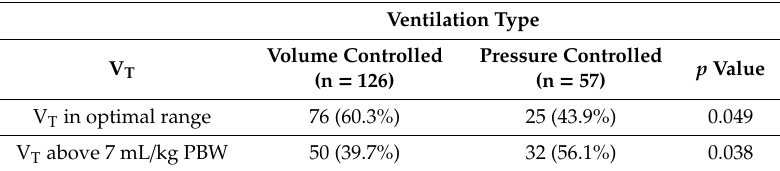
Table 2. Impact of ventilation type on V T classification.